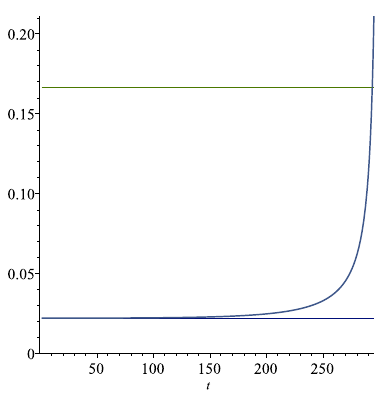
Figure 9. Recursive utility. Drawdown rate vs. return; γ < ρ